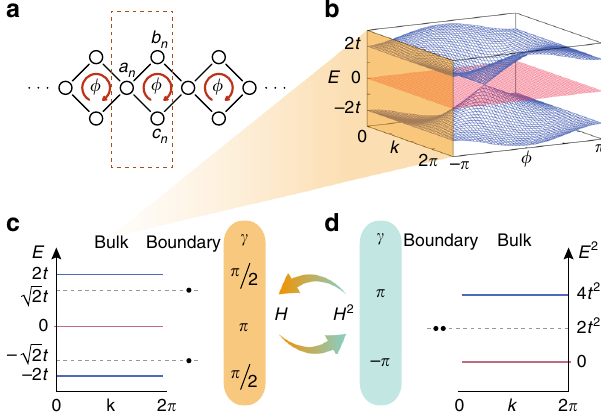
Fig. 1 The Aharonov – Bohm cages. a A chain of Aharonov – Bohm cages [cf. Eq. (1)], with three sites a n , b n , c n in the n th unit cell and a fl ux ϕ threading each plaquette. b The energy dispersion E ( k ) of the chain as a function of the fl ux ϕ . c The energy dispersion E ( k ) at ϕ = π consists of three fl at band at energies 0 and ±2 t . The band at E = 0 has a quantized Zak's phase γ = π while the other two bands show a non-quantized winding of π ∕ 2. At a termination of the chain with site a n , two in-gap boundary states appear at ffiffiffi p E ¼ ± t . d Squaring the Hamiltonian (1) yields a model (2) with one fl at 2 band at E = 0 and two degenerate fl at bands at E = 4 t 2 . Both bands have a quantized Wilzcek – Zee phase ∣ γ ∣ = π